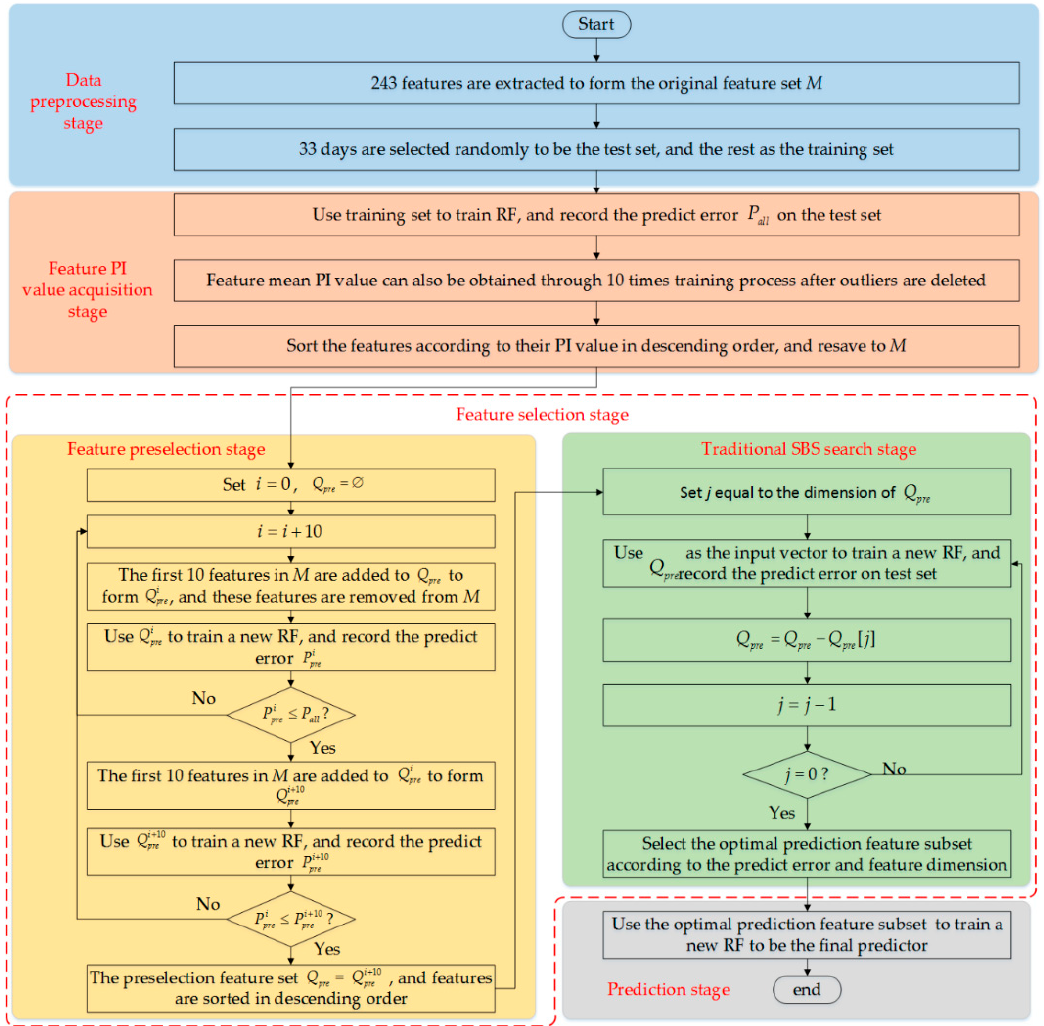
Figure 1. Flowchart of the algorithm.